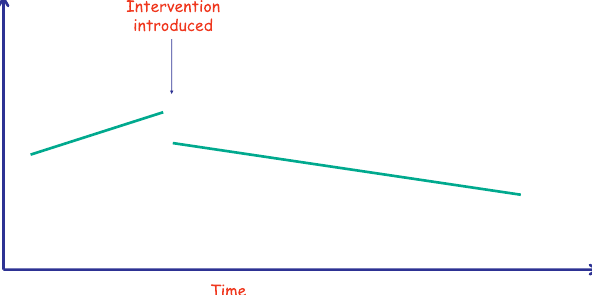
Figure 1. An ITS is a Quasi-Experimental Design that Can Be Used to Evaluate an Intervention when a True Randomised Controlled Experi- ment Is Not